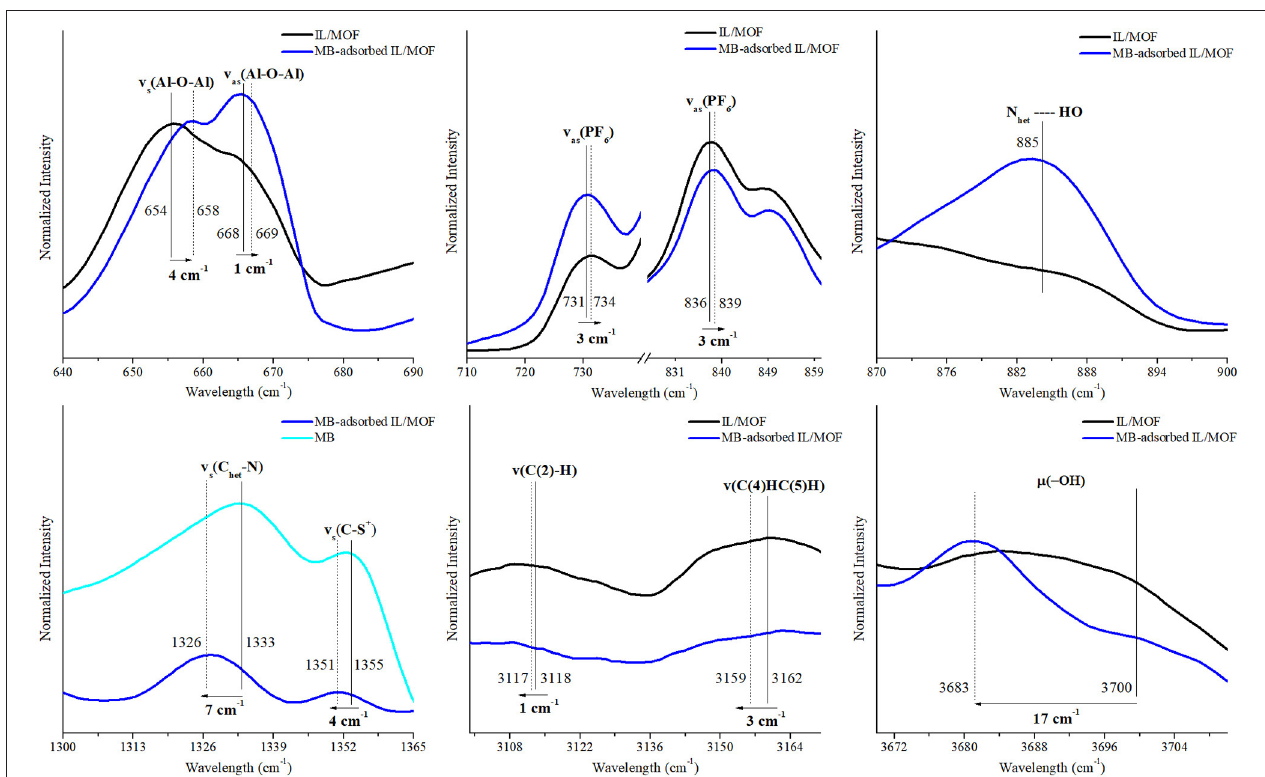
FIGURE 7 | Changes in the characteristic FTIR peaks of [BMIM][PF 6 ]/MIL-53(Al) composite and MB after MB adsorption. FTIR, Fourier transform infrared; MB, methylene